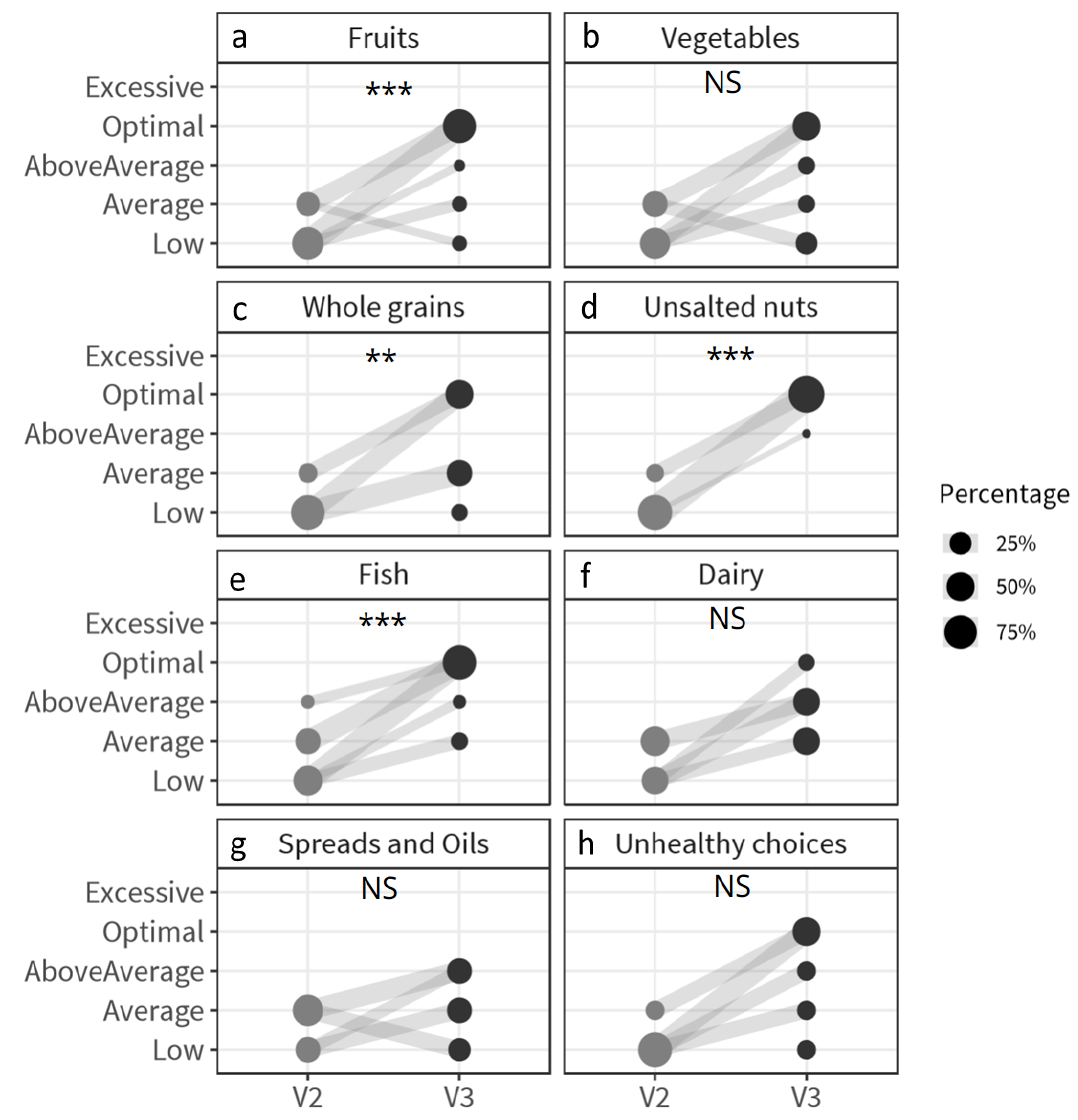
Figure 4. Fluctuation plots of the percentage of goal-setting participants receiving PNA per nutrition intake status before (V2) and after the nine-week intervention period (V3) for ( a ) fruit: n = 23; ( b ) vegetables: n = 8; ( c ) whole grain: n = 18; ( d ) unsalted nuts: n = 29; ( e ) fish: n = 16; ( f ) spreads and oils: n = 11; ( g ) dairy: n = 9; ( h ) unhealthy choices: n = 6. The size of the circles represents the percentage of participants who set a goal for that specific food category and the lines represent participant migration of NIS between V2 and V3. The size of the lines represent the percentage of participants that migrated between NIS during the intervention period (V2 to V3). ** p < 0.01, *** p < 0.001, NS: non-significant. NIS—nutrition intake status; PNA—personalized nutrition advice.